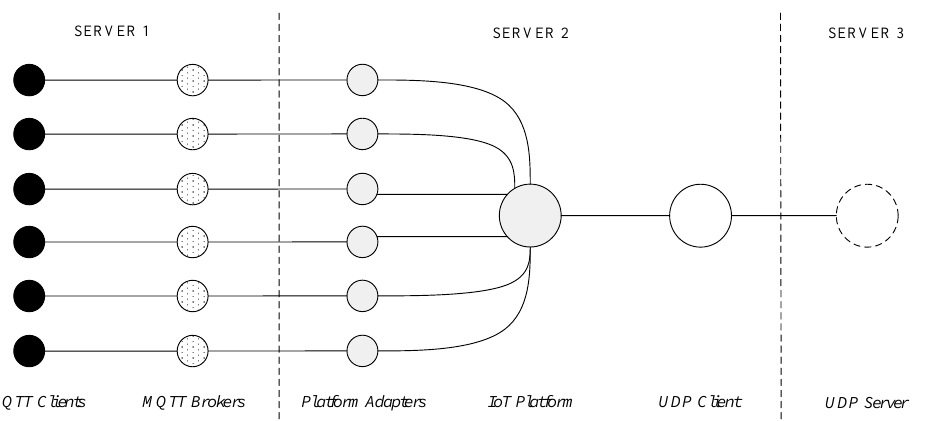
Figure 9. The test setup. Every test consists of six MQTT clients, subscribed to six MQTT brokers. The clients forward their data to the IoT platform that is being tested. A UDP client fetches data from the platform and forwards the packet to a UDP server.